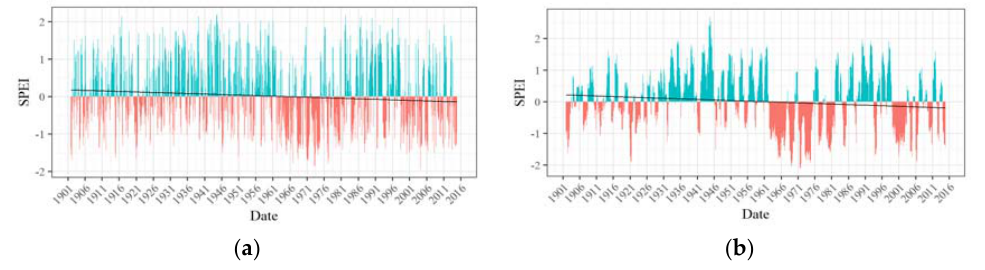
Figure 5. ( a ) 3 ‐ month and ( b ) 12 ‐ month SPEI time series of Zone 1.